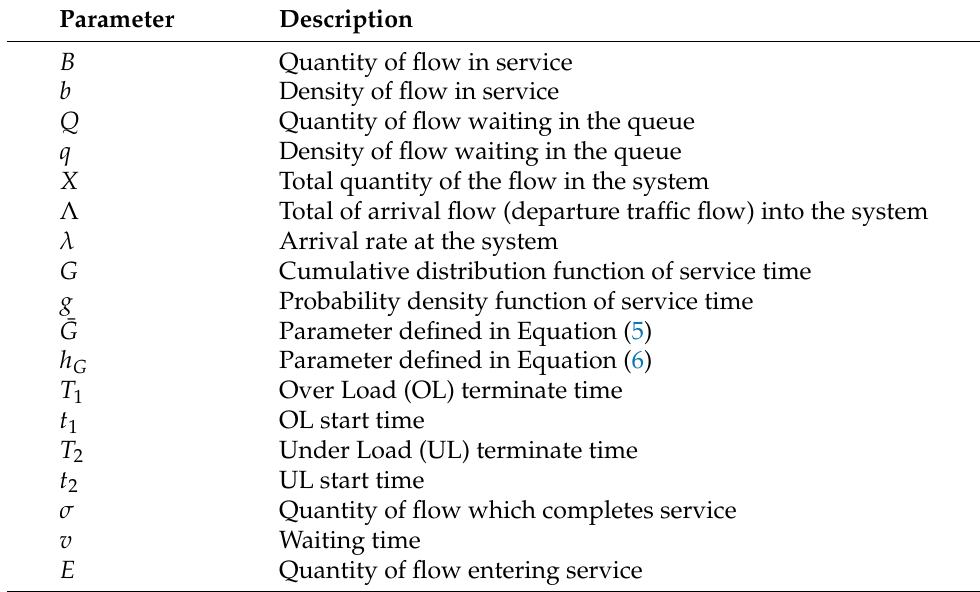
Table 2. Notation of the